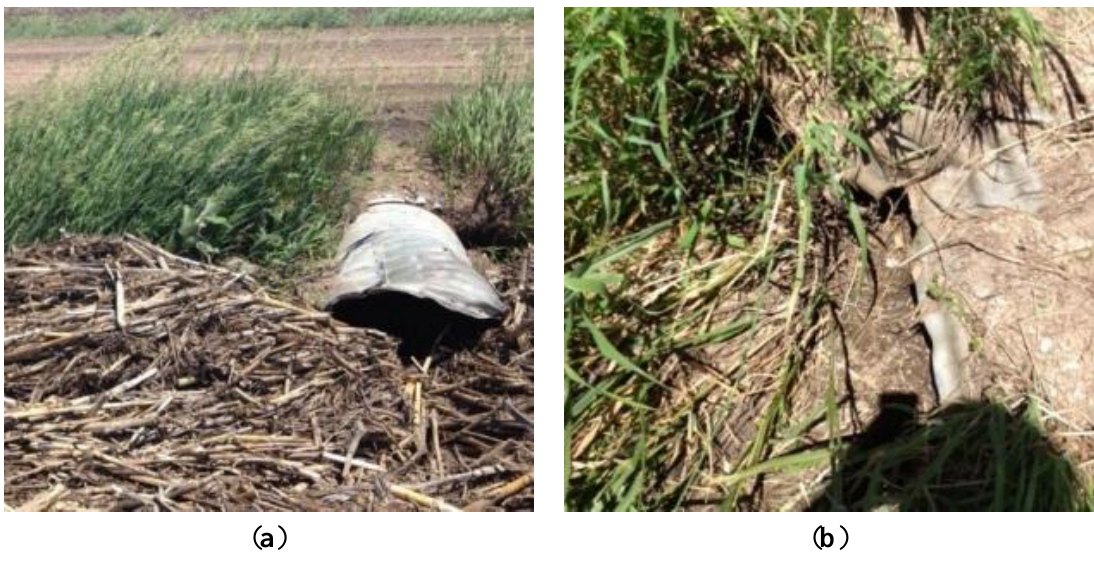
Figure 6. Culverts silted by ( a ) corn stalks and ( b )